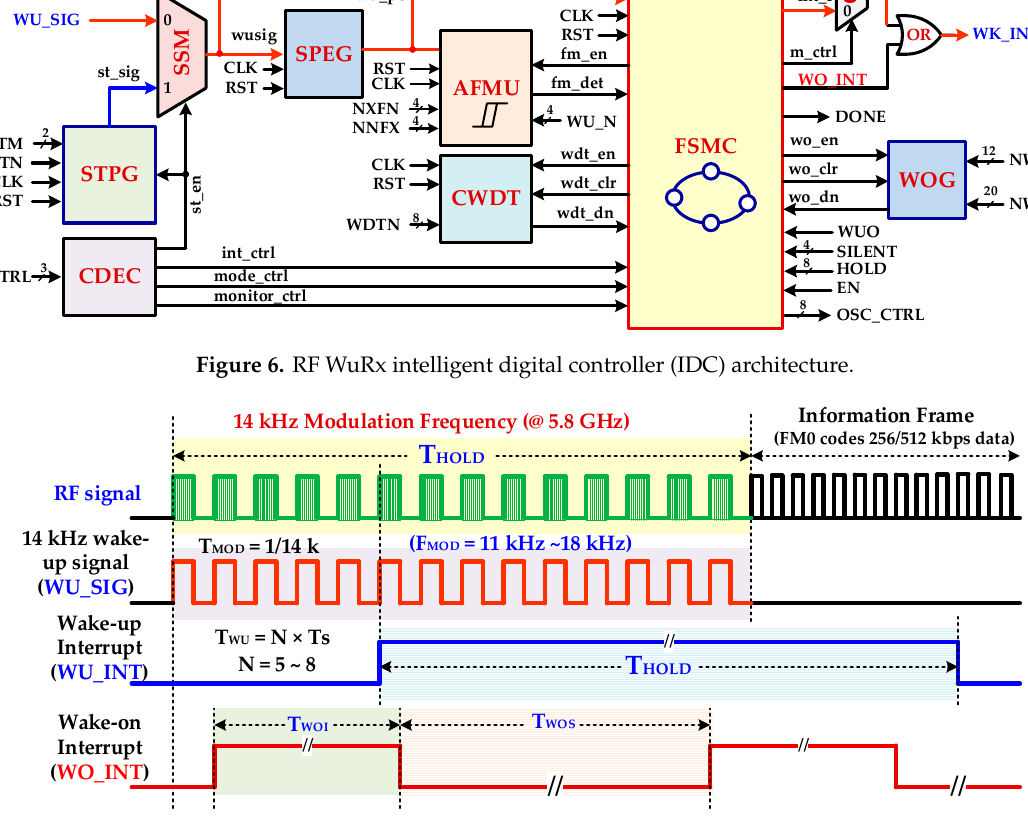
Figure 7. RF wake-up and wake-on interrupt timing diagram.